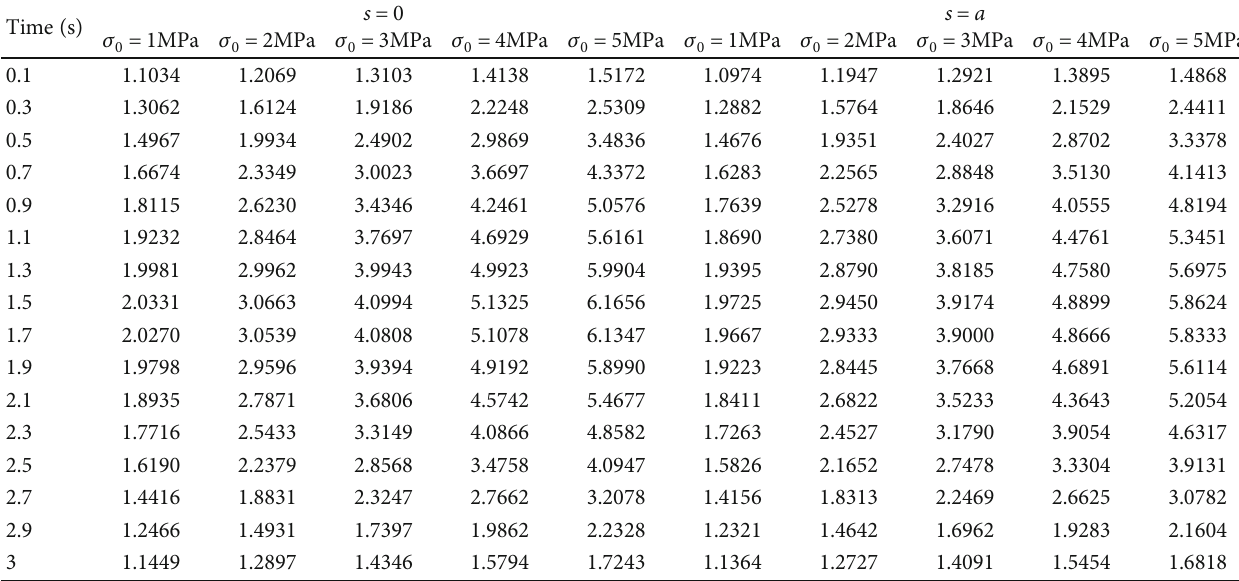
ΙΙ under di ff erent dynamic load amplitudes ( σ d